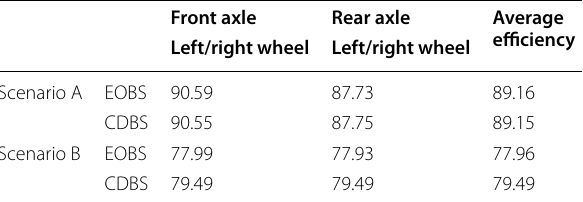
efficiency Left/right wheel Left/right wheel